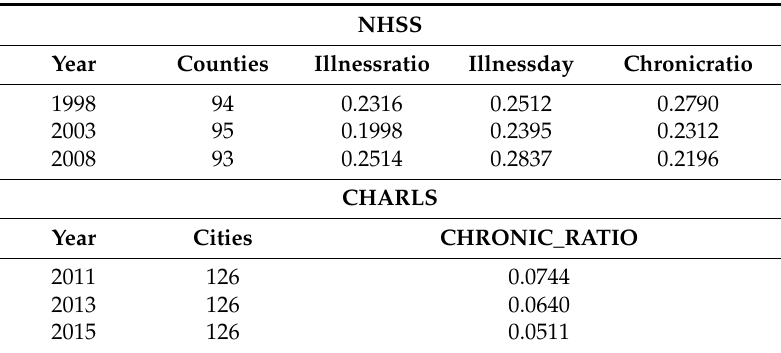
Table 3. Gini coefficients of health